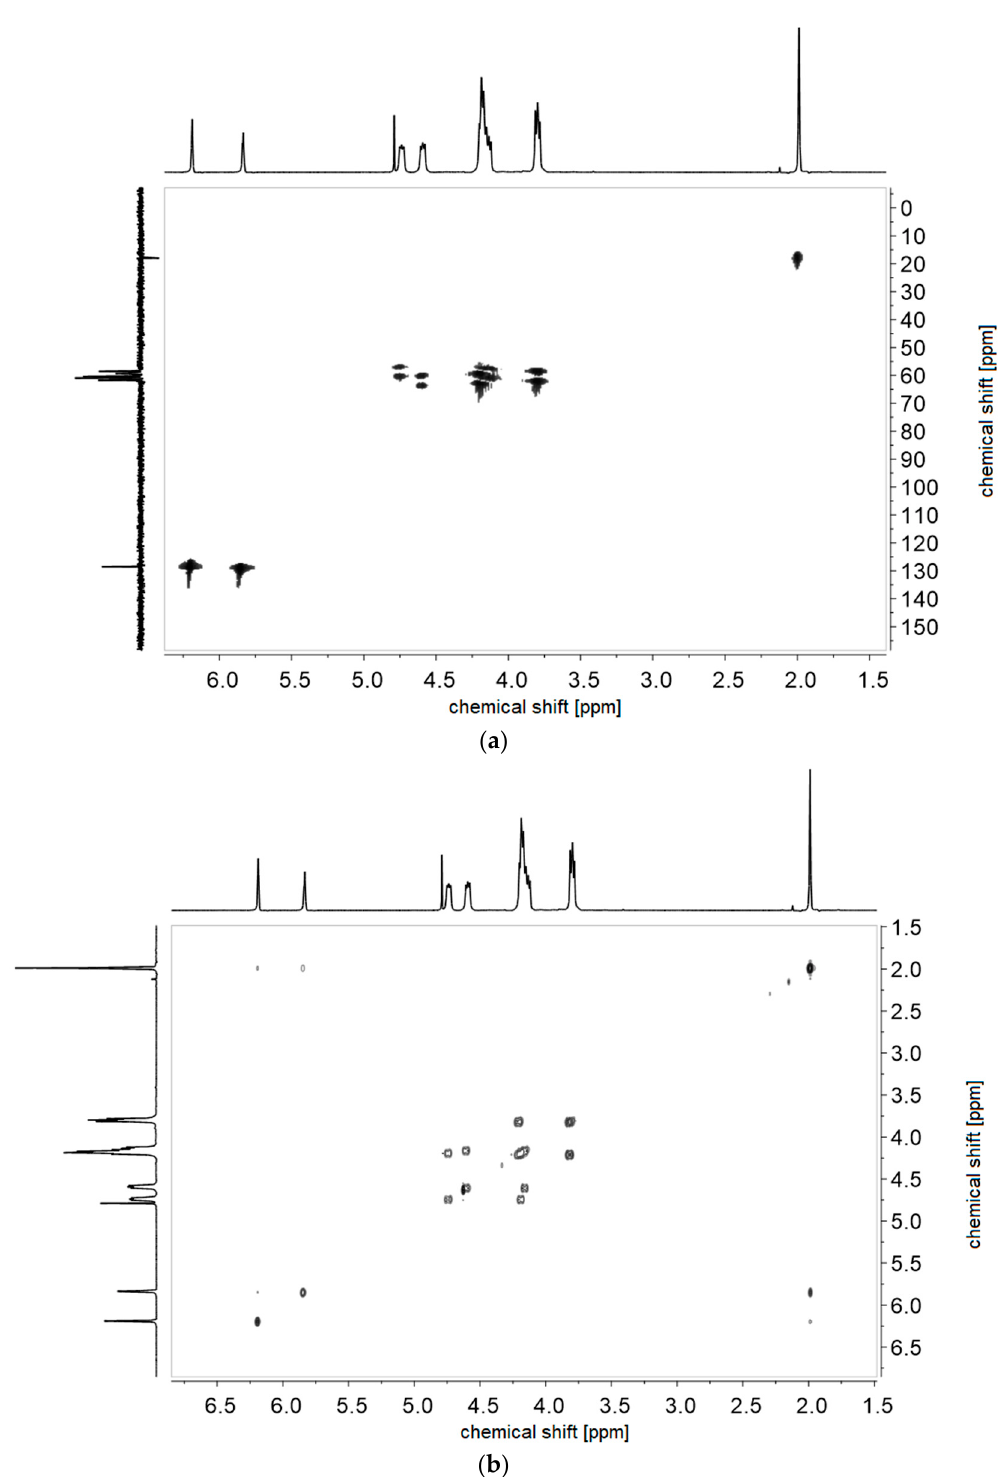
Figure A10. ( a ) 1 H- 1 H-COSY- and ( b ) 1 H- 13 C-HMQC NMR-spectra of monomer of 5c in D 2 O.